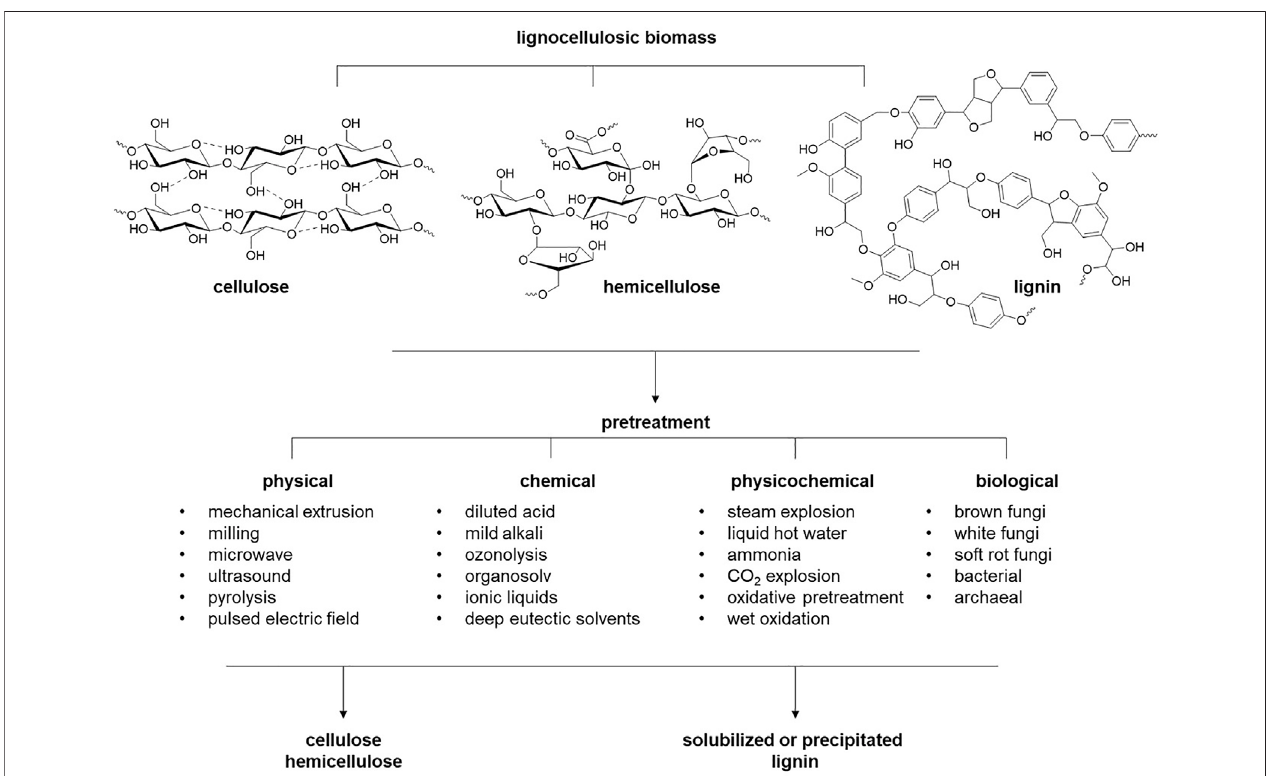
FIGURE 2 | Pivotal pretreatment approaches for the valorization of lignocellulosic biomass.